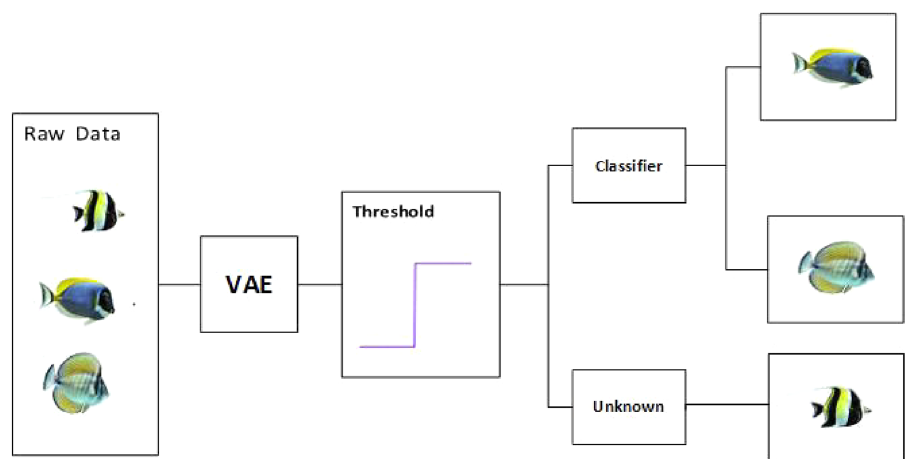
Fig. 1 Blockdiagram of the proposed